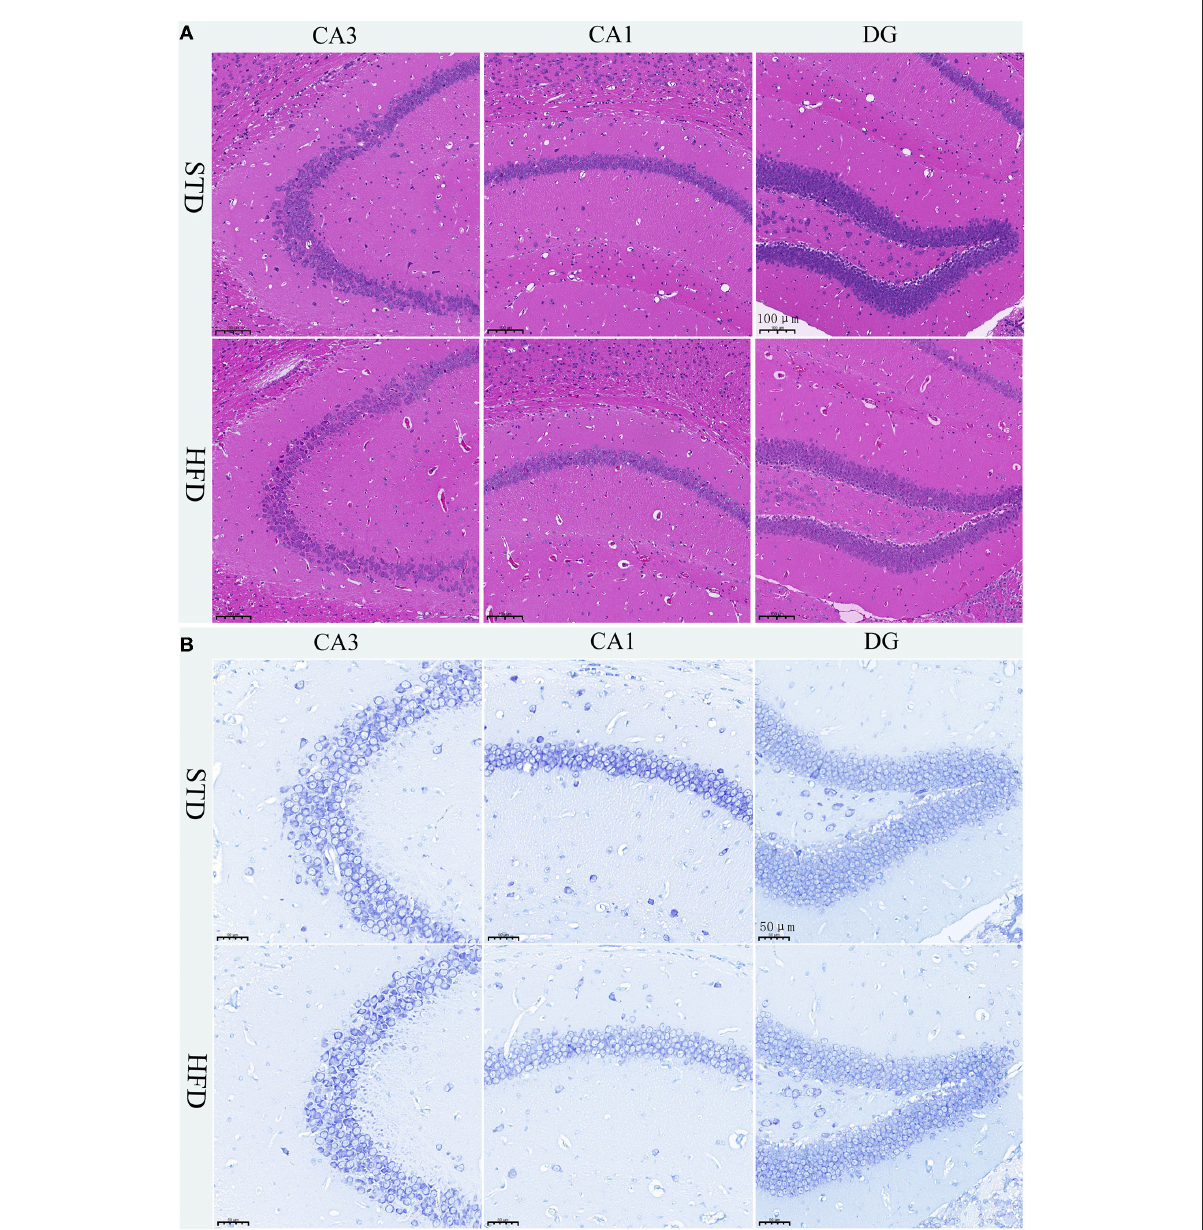
FIGURE4 Histopathological staining and Nissl staining of brain tissue in mice. (A) HE staining in the hippocampal CA1, CA3, and DG regions for each group. (B) Nissl staining in the hippocampal CA1, CA3, and DG regions for each group. Brain tissues from three mice of each group were used for pathological